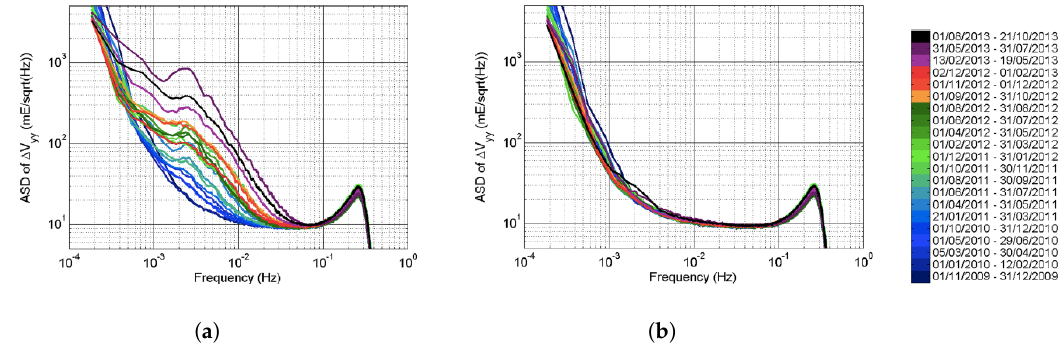
Figure 2. Amplitude spectral density (ASD) of the residuals ∆ V yy of the GOCE SGG data before ( a ) and after ( b ) the reprocessing according to the work in [18]. The residuals are computed with respect to the GOCO03s model [19]. The individual curves correspond to the bimonthly GOCE data periods. Figure is adapted from the work in